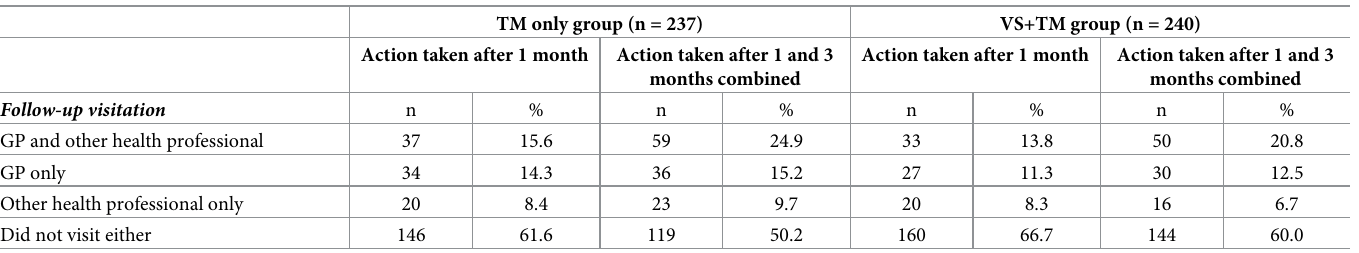
Table 2. One and three-month follow-up visitations with General Practitioner (GP) and other health professionals, by group (N = 477). TM only group (n = 237)